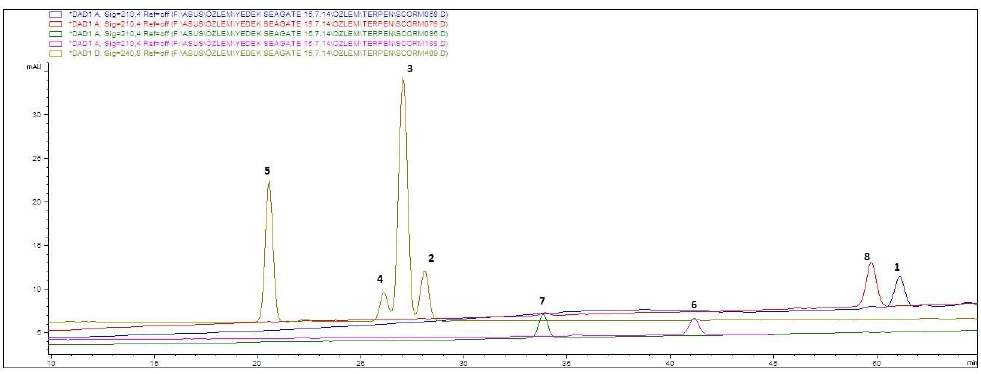
Figure 1. Superimposed representative HPLC chromatograms of compounds 1 and 6 – 8 at 210 nm and 2 – 5 at 240 nm: taraxasteryl acetate ( 1 ) 33 µg·mL −1 ; 3β-hydroxy-fern-7-en-6-one acetate ( 2 ) 20 µgmL −1 ; urs-12-en-11-one-3-acetyl ( 3 ) 65 µg·mL −1 ; 3β-hydroxy-fern-8-en-7-one acetate ( 4 ) 31 µg·mL −1 ; olean-12-en-11-one-3-acetyl ( 5 ) 65.5 µg·mL −1 ; α-amyrin ( 6 ) 23 µg·mL −1 ; lupeol ( 7 ) 26 µg·mL −1 ; lupeol acetate ( 8 ) 44 µg·mL −1 .